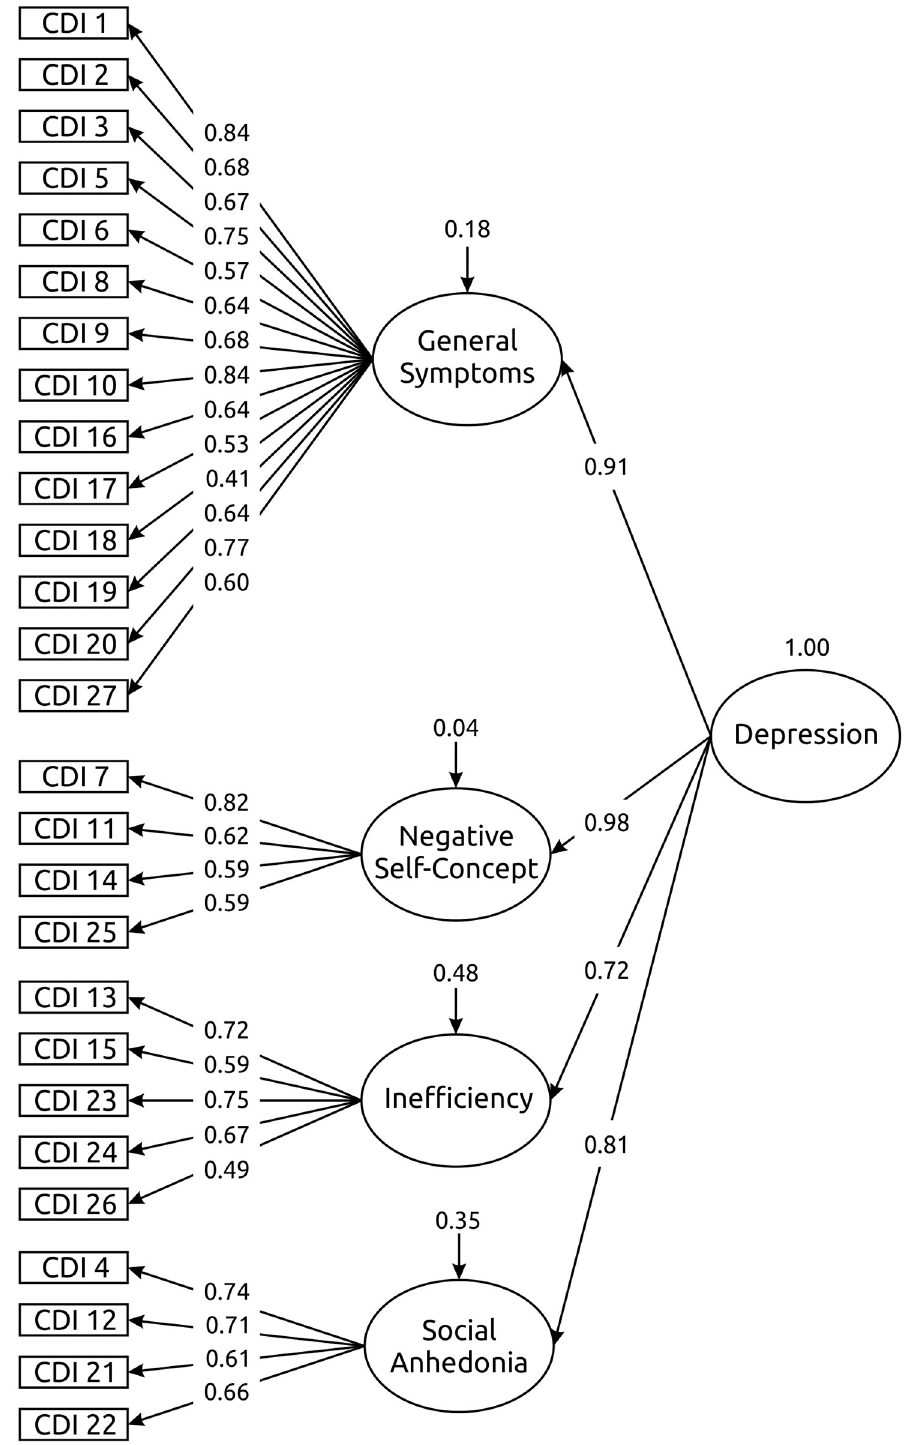
Fig 1. The second-order factor structure of the CDI. Standardized regression coefficients are stated; error terms (uncorrelated) are omitted for the sake of clarity.